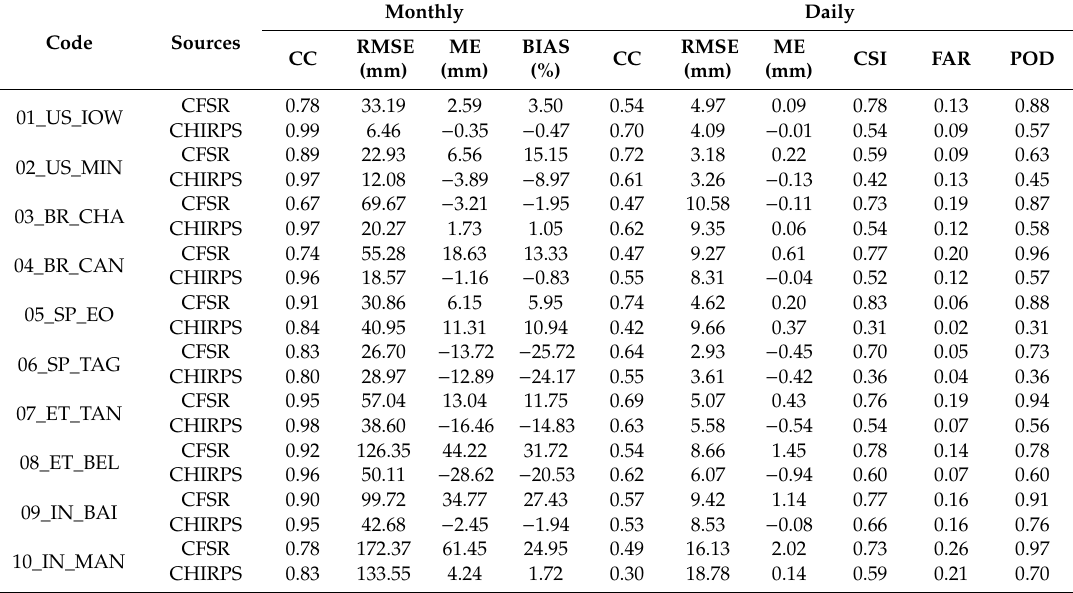
Table 4. Monthly and daily statistical and contingency indices for the CFSR and CHIRPS precipitation products as compared to the rain gauge observations.